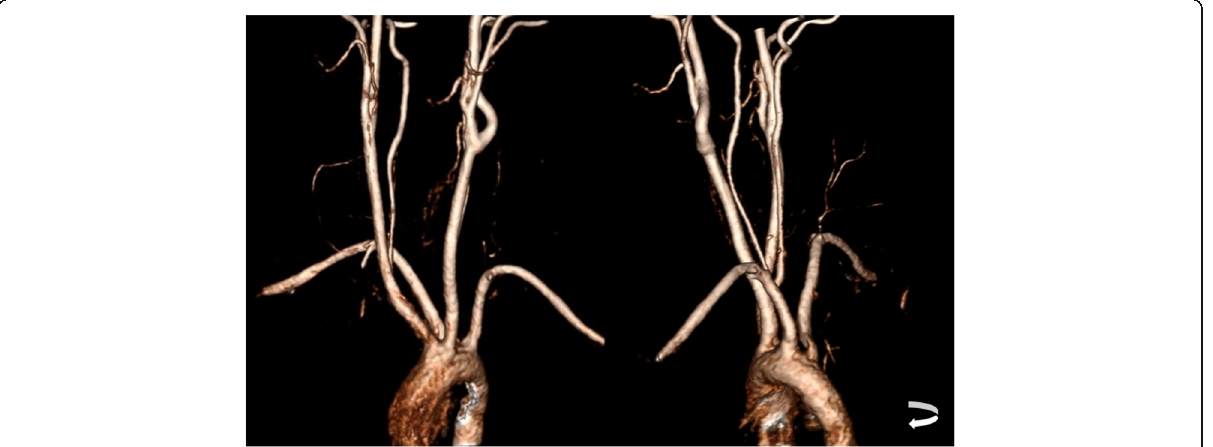
Fig. 20 Three-dimensional reconstruction of a CT angiography of the supra-aortic trunks of a 49-year-old patient with Down syndrome depicting an aberrant right subclavian